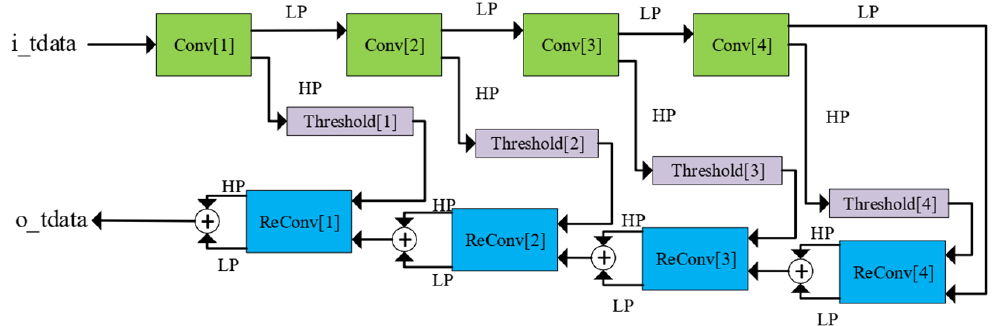
Figure 10. Coarse view of the Denoise IP